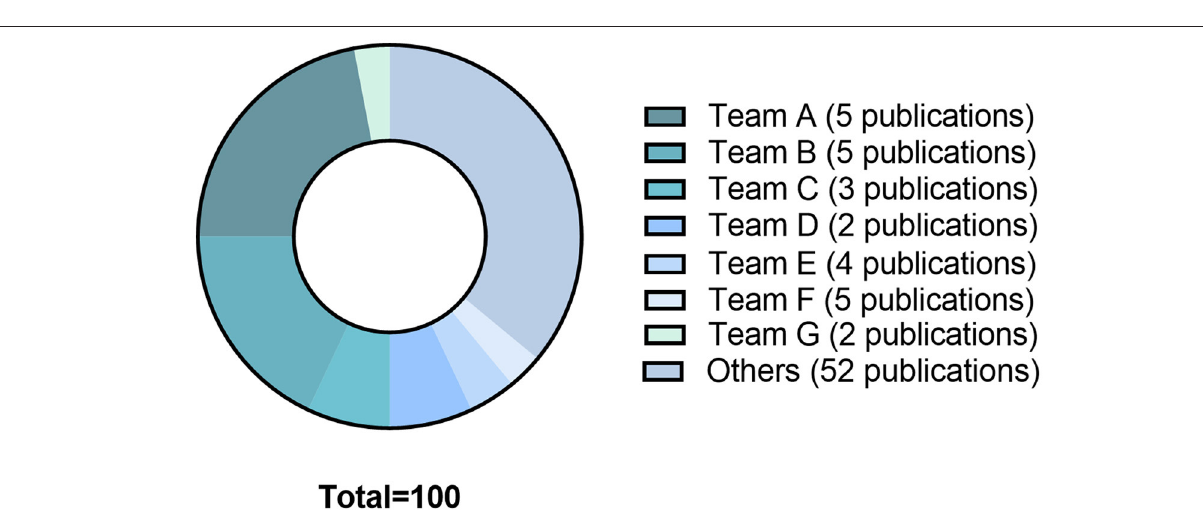
FIGURE 3 | The 78 studies included in the systematical review generated since their publication 3681 citations. The graph shows the distribution of citations by teams: Team A: Bederson, Mount Sinai School of Medicine, New York; Team B: Prunell, Department of Clinical Neuroscience, Section for Neurosurgery,